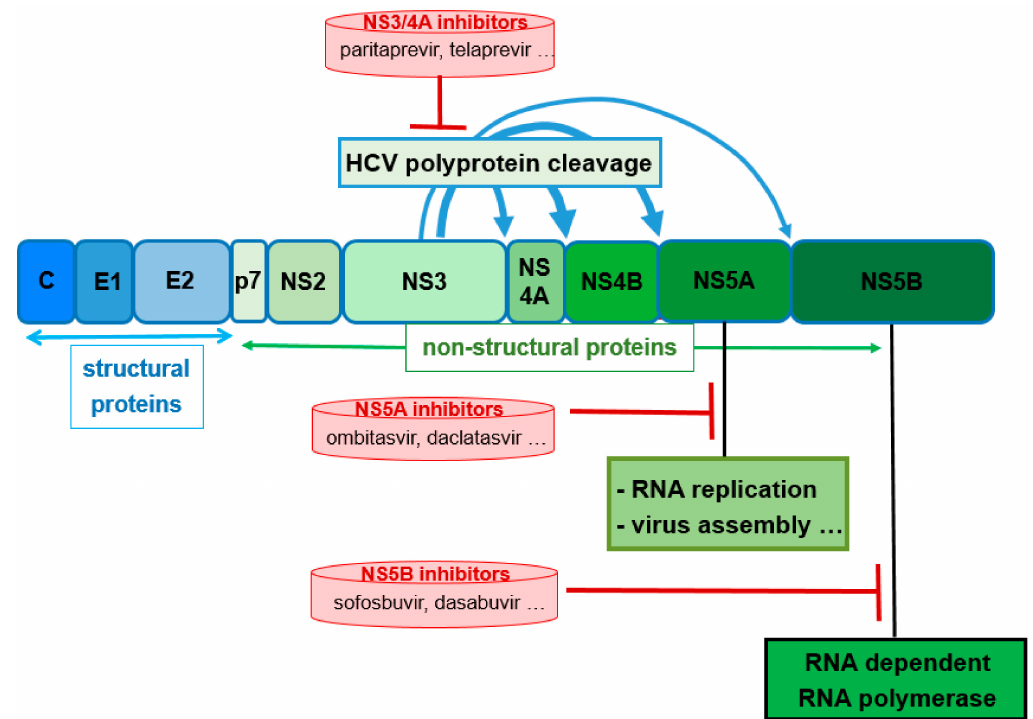
Figure 12. The HCV polyprotein is a single protein (around 3000 amino acids), which undergoes cleavage catalyzed by host endopeptidases (for structural proteins) and autoproteolytically (indicated by blue arrows) by its own non-structural protein NS3/4A with protease activity. This results in the formation of structural proteins (core and envelope proteins) and non-structural proteins (p7, NS2, NS3, NS4A, NS4B, NS5A, and NS5B). Direct-acting antiviral drugs interact with diverse non-structural proteins (indicated by red bars)